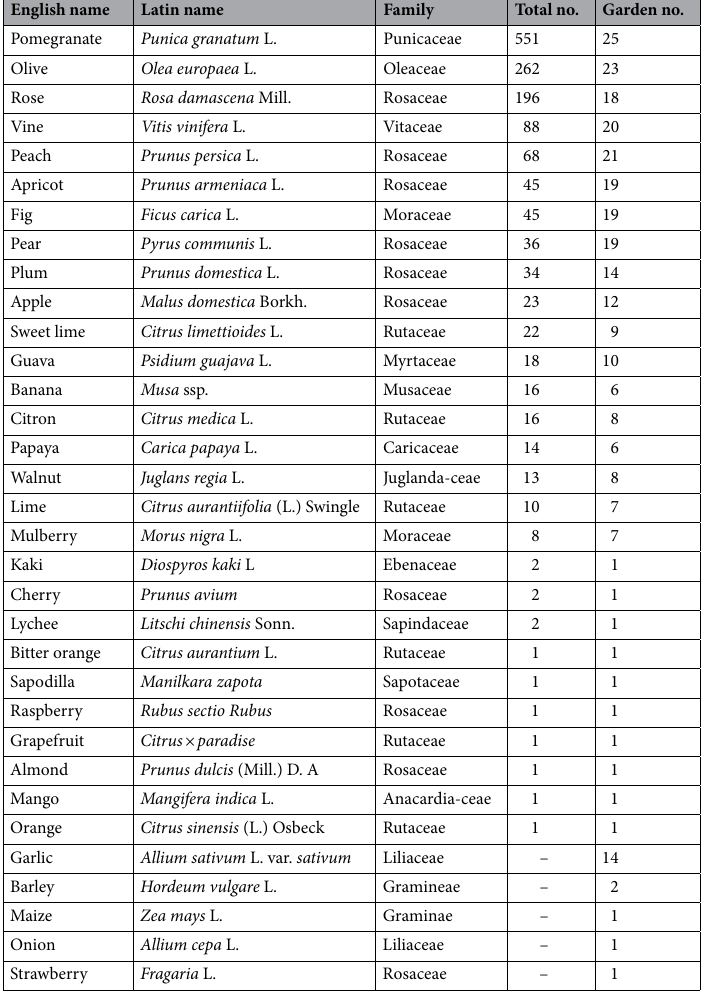
Table 1. Species occurrence in the homegardens of the town Sayh Qatanah (Al Jabal Al Akhdar, northern Oman) in 25 randomly selected